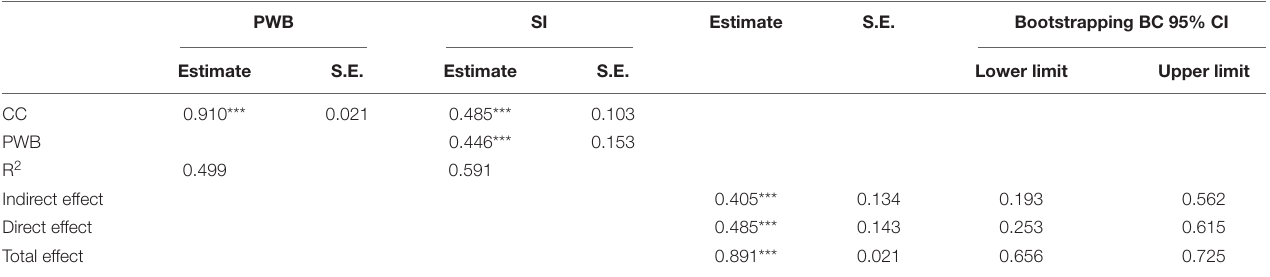
TABLE 7 | Mediating effect of social integration between cognitive communion and psychological well-being. PWB SI